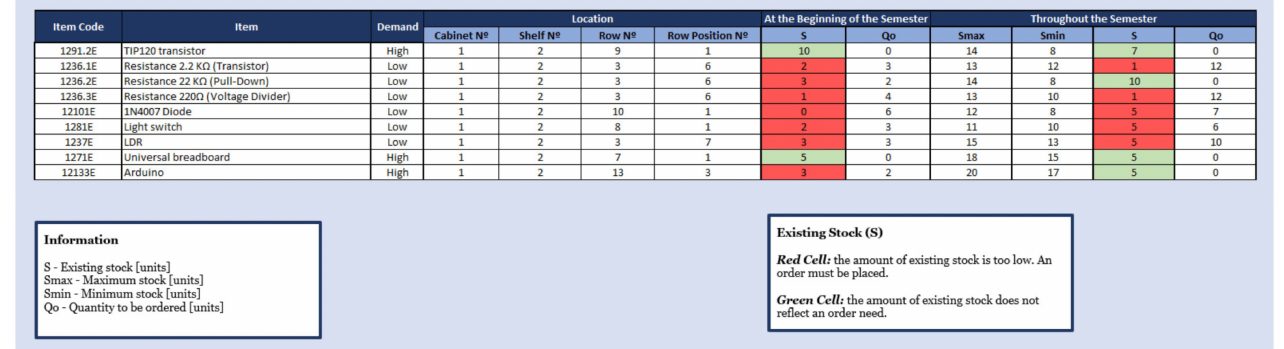
Figure 10. “e-Kanban” sheet.